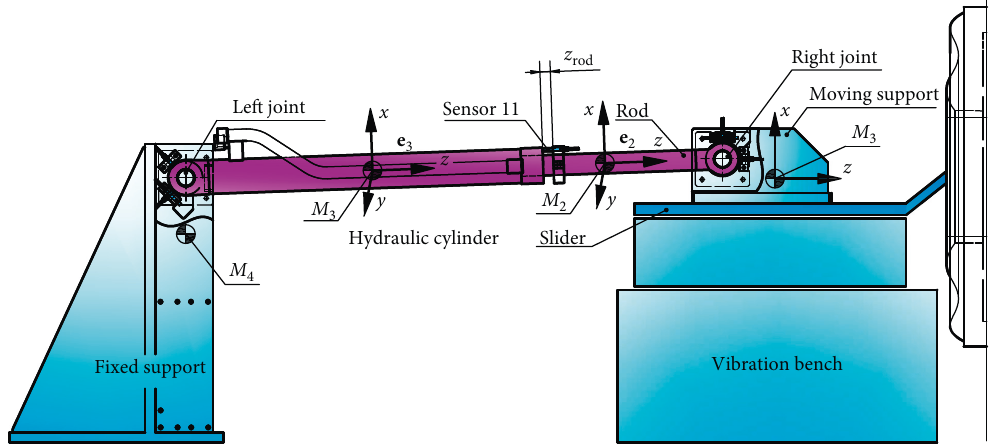
Figure 11: Schematic overview of numerical example with 3D clearance joints. Table 1: Parameters of hydraulic cylinder.